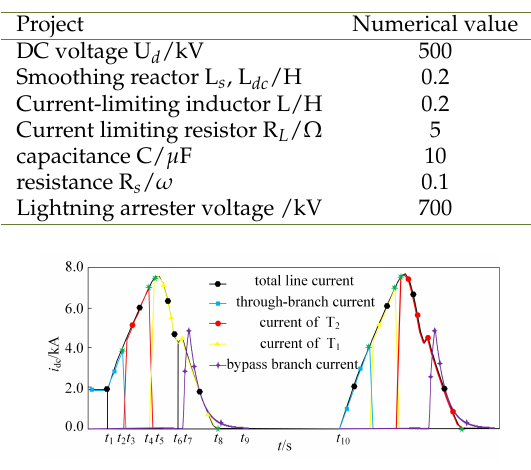
Fig. 8. Simulation circuit